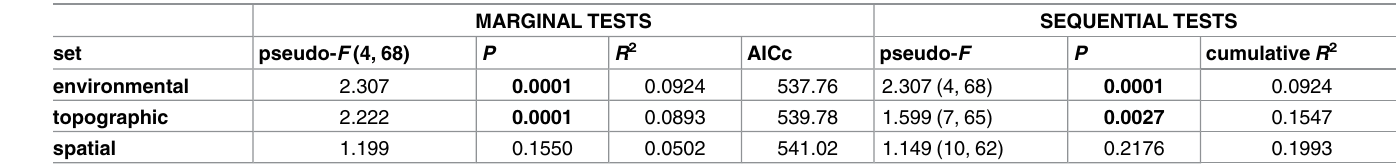
Table 1. Results of DISTLM analysesamong sets of